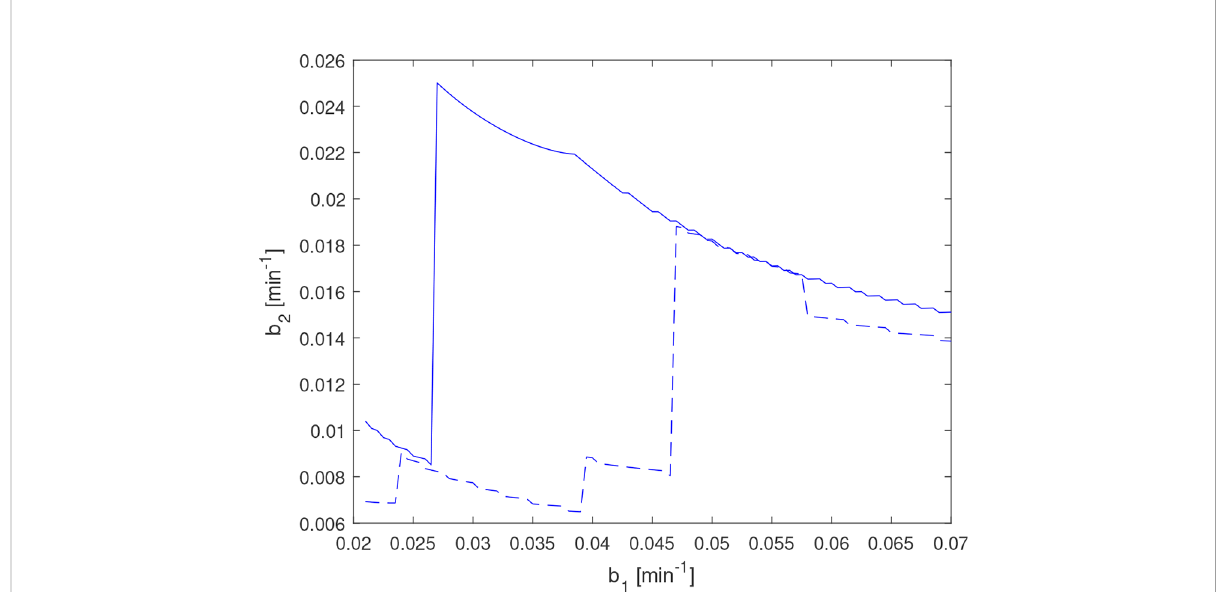
FIGURE 14 ^ g P for amenorrheic exerciser estimated with complete data (dashed line) and with the 220 min measurement in the data set (see Figure 11) removed (solid line). The discontinuity at b 1 =0.047 min − 1 for the dashed line corresponds to a reduction in the number of estimated impulses for b 1 ≤ 0.047min − 1 , which in this instance results in a signi fi cantly worse model fi